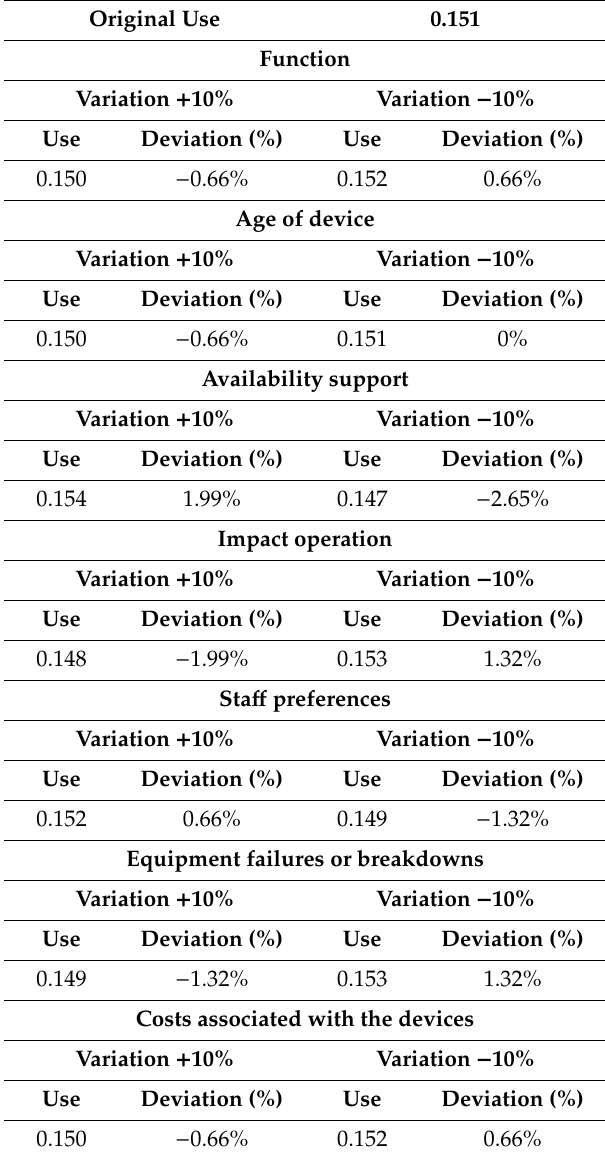
Table 33. Sensitivity analysis for video